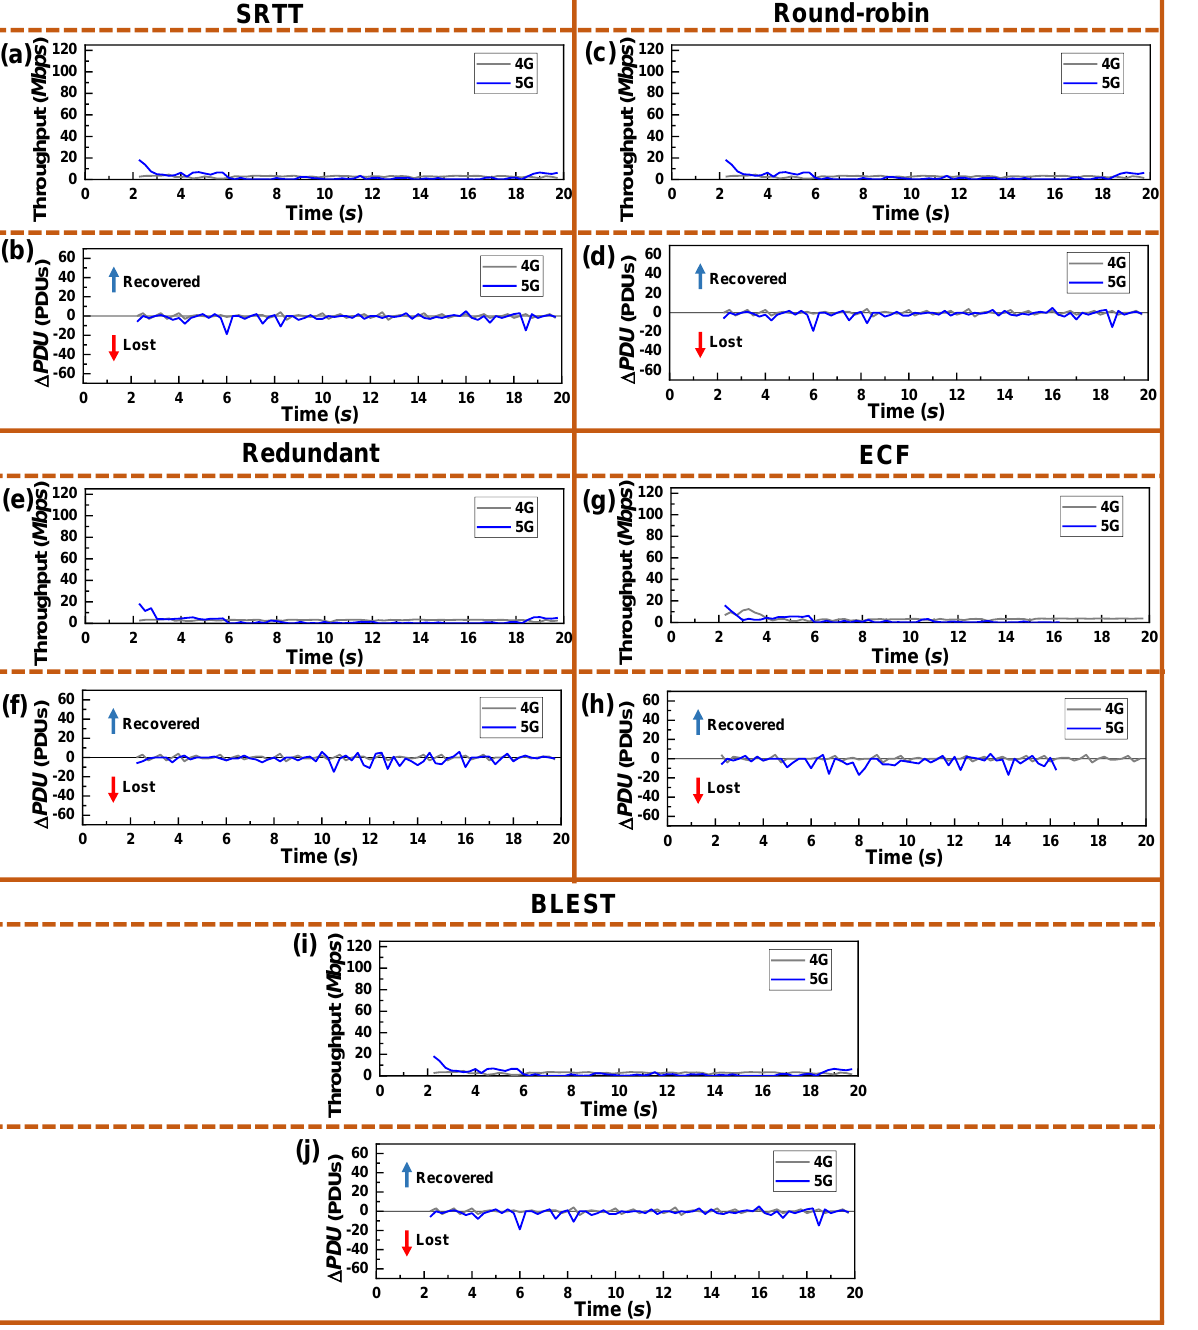
Figure 11. Real-time performance of the tested MPTCP schedulers for wVegas as a CCA in terms of throughput and Δ PDU for: ( a , b ) SRTT, ( c , d ) Round-robin, ( e , f ) Redundant, ( g , h ) ECF, and ( i , j ) BLEST, respectively.